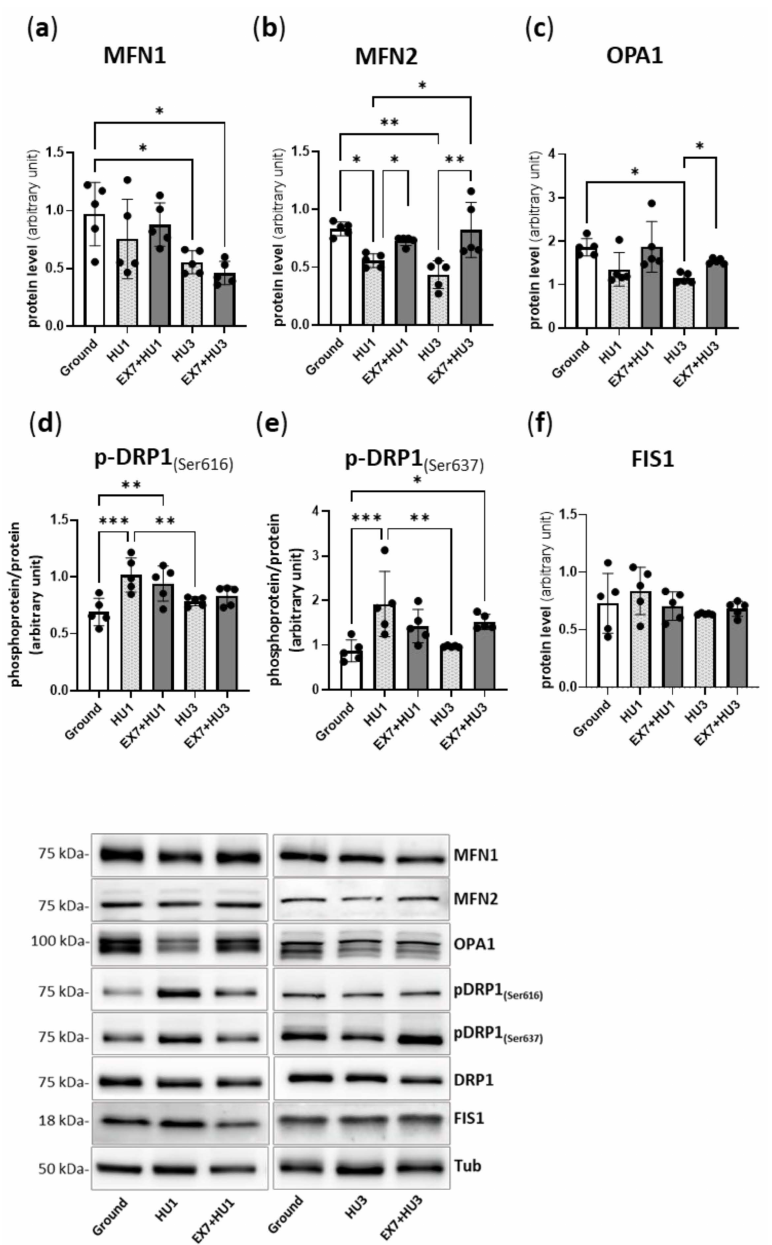
(Figure 5d,e). The protein level of pro-fission marker FIS1 was unchanged in all experimen- tal groups (Figure 5f).